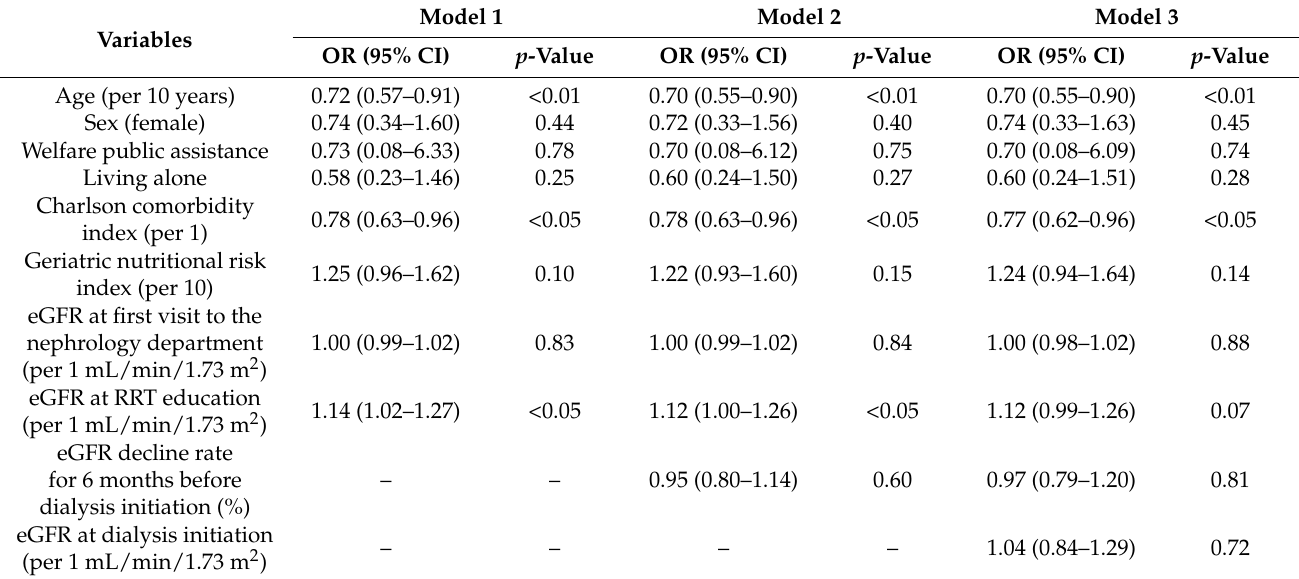
Table 4. Results of multivariate logistic regression analyses associated with PD